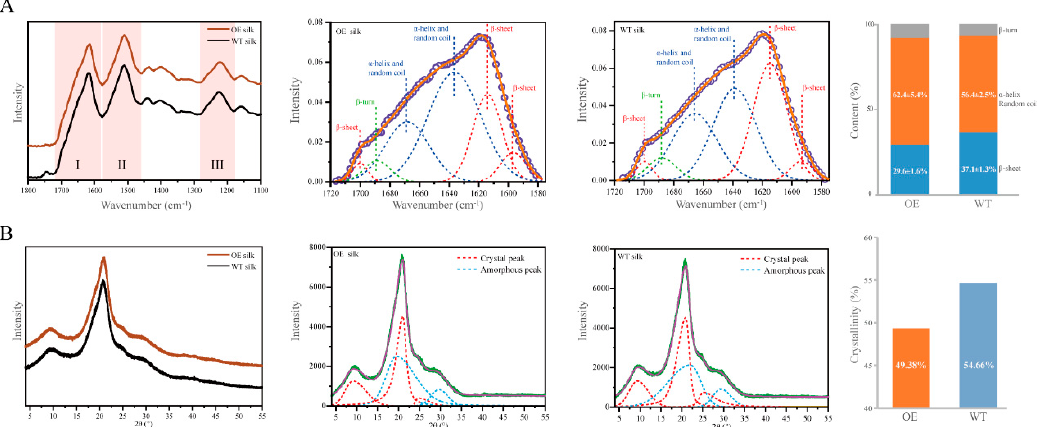
Figure 5. Secondary structural characteristics and crystallinity of silk fibers. ( A ). ATR-FTIR spectra from 1100 to 1800 cm − 1 of silk from the silks of the OE and WT. Deconvolution of the corresponding amide I band. Comparison of the β -sheet content in the silks between the OE and WT. ( B ). X-ray di ff raction di ff ractograms of silk from the silks of the OE and WT. Deconvolution of the silk di ff ractograms, with intensity as a function of the scattering angle 2 θ . Comparison of the crystallinity of the silks between the OE and WT.